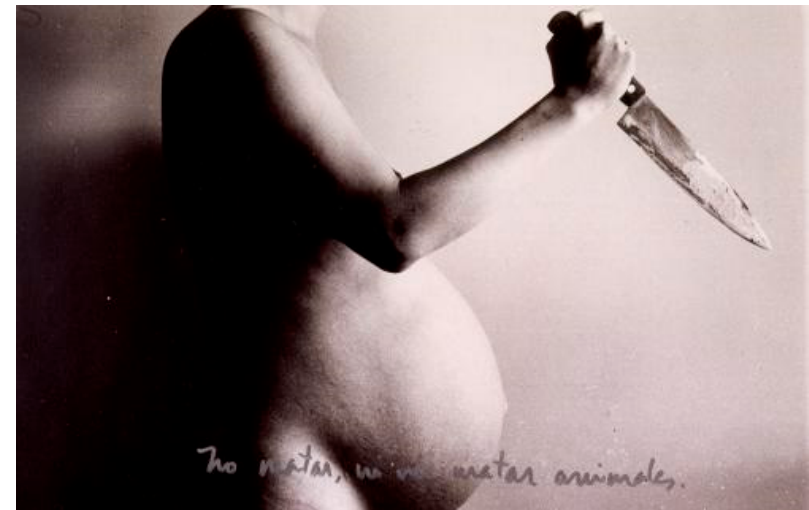
Figure 3. Marta María Pérez Bravo, No matar, ni ver matar animales (Neither Kill, Nor Watch Animals Figure 3. Marta Mar í a P é rez Bravo, No matar, ni ver matar animales (Neither Kill, Nor Watch Animals Being Killed), 1986. Courtesy of the artist. Being Killed), 1986. Courtesy of the